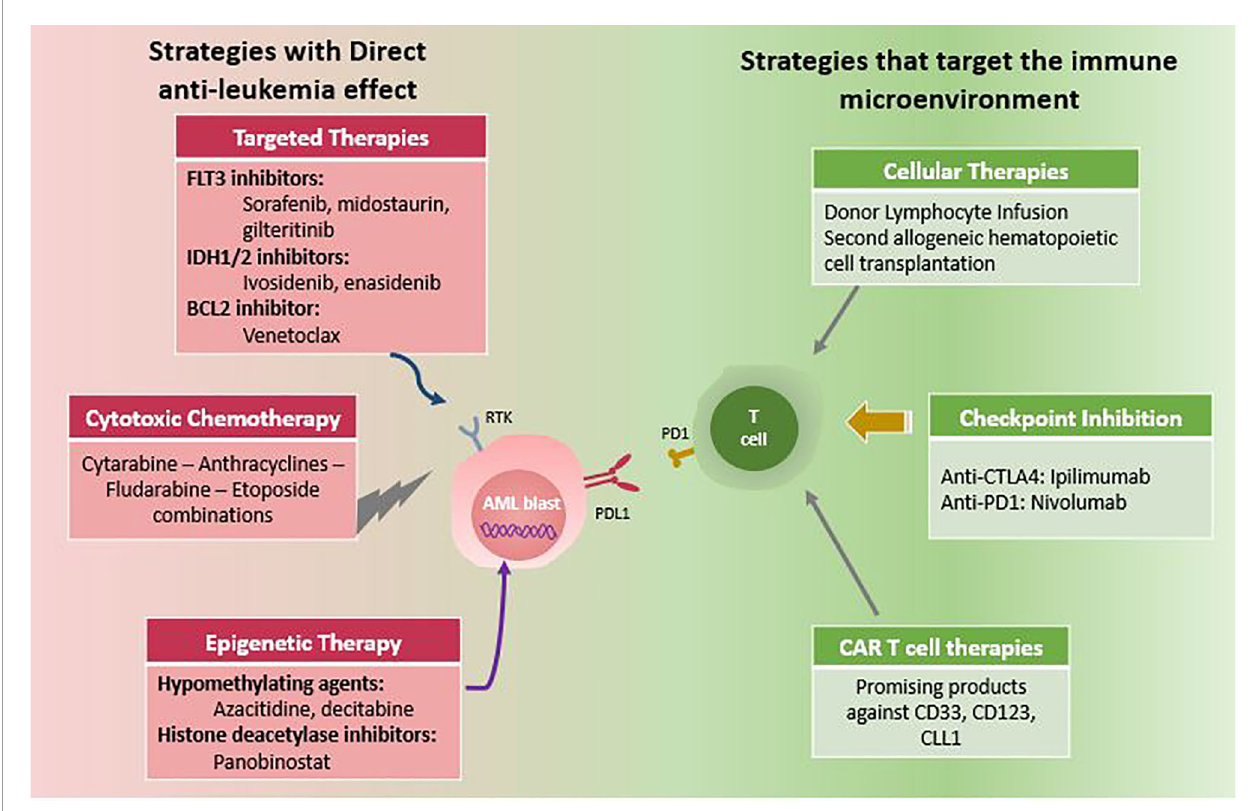
FIGURE 1 | Therapeutic options for post-transplant AML relapse. Note: Combination of two or more options are increasingly